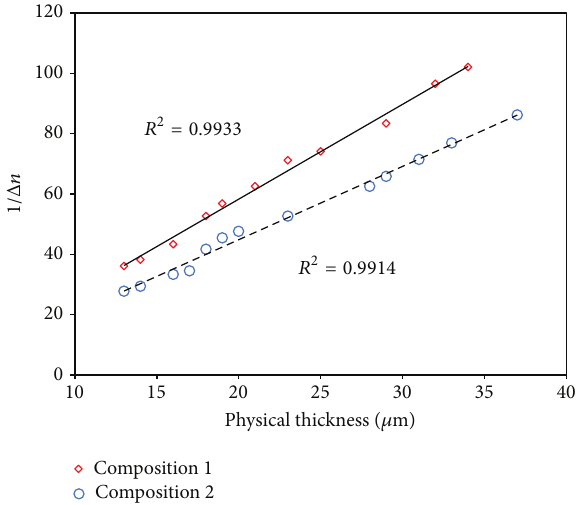
Figure 5: The inverse of the refractive index modulation as a func- tion of physical thickness for the layers with chemical composition 1.